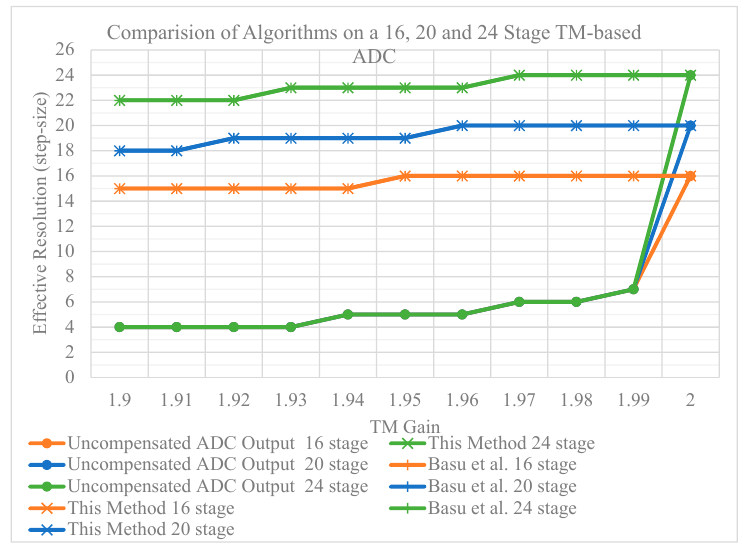
Figure 17. Comparing algorithm performance on the 16-, 20-, and 24-TM-stage TM-based ADC models.